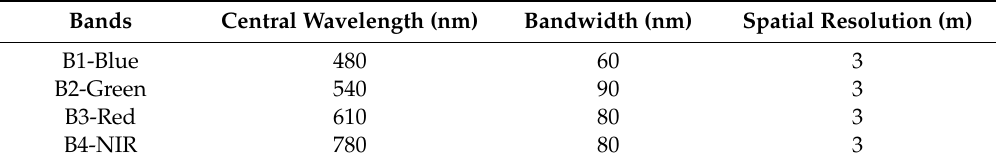
Table 2. PlanetScope band